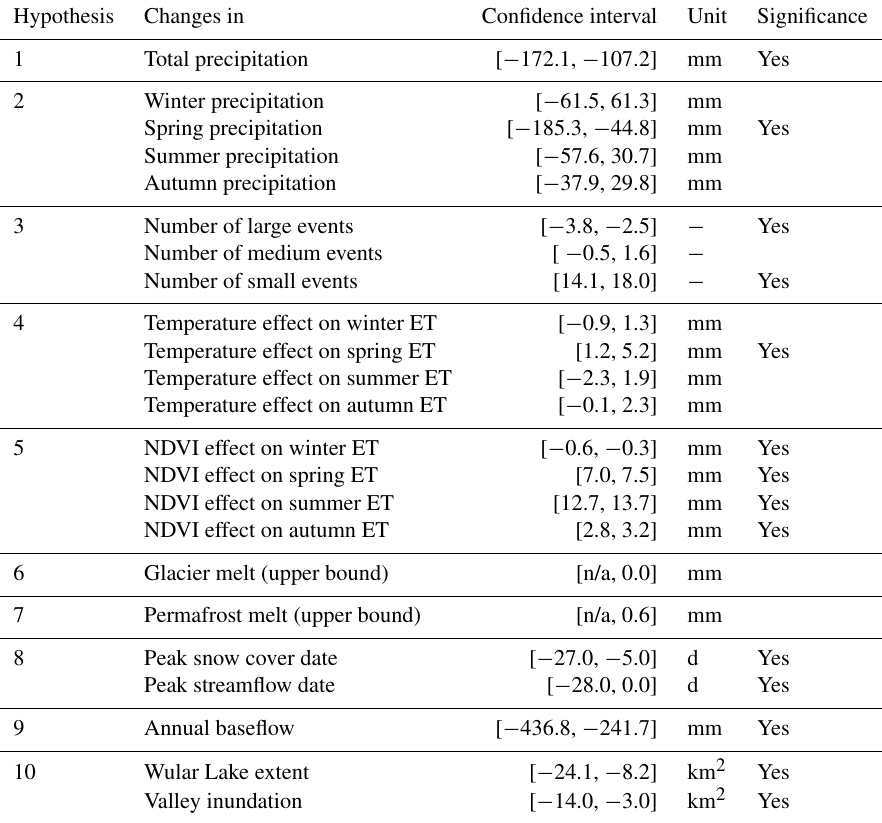
Table 2. Summary of hypothesis tests with 95% bootstrapped confidence intervals. Statistical significance occurs when the confidence interval excludes zero. Note that n/a stands for not